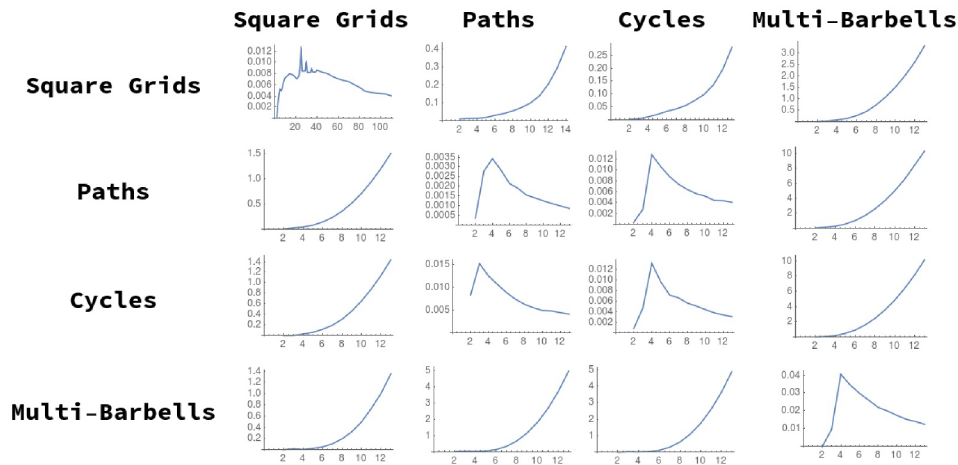
Fig 9. Cauchy-like behavior of graph distance as a function of sequence index, n . The distance between successive square grids and all other graph sequences appears to diverge (the same behavior is seen for k-barbells). Notably, the distance between Grid and Grid ( does not appear to converge, until much higher values of n ( n > 100) than n × n n +1) × ( n +1) the other convergent series. This may be because the distances calculated are an upper bound, and may be converging more slowly than the ‘true’